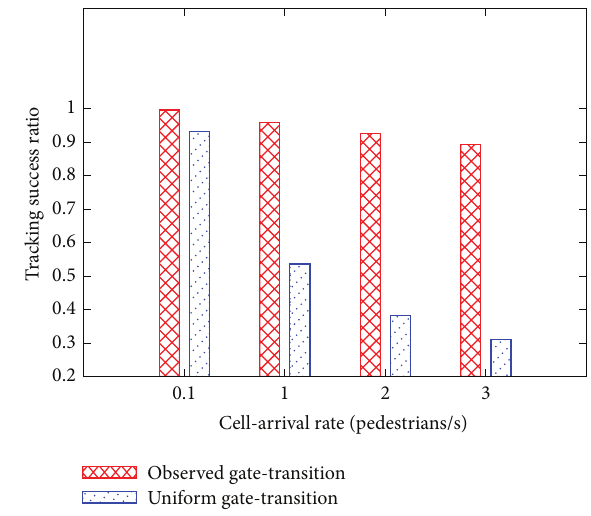
Figure 10: Tracking success ratio plotted against the reliability . threshold 𝑟 th